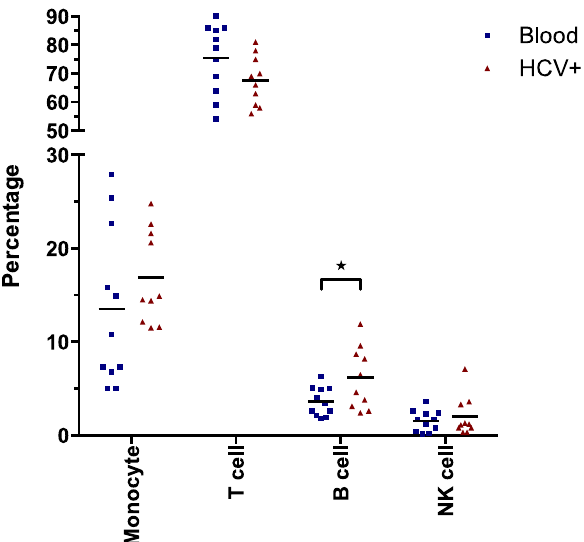
Figure 2. Phenotypic characterization of PBMCs. PBMCs from blood donors and HCV + patients were stained with labeled antibodies that recognize specific surface markers and analyzed by FACS.